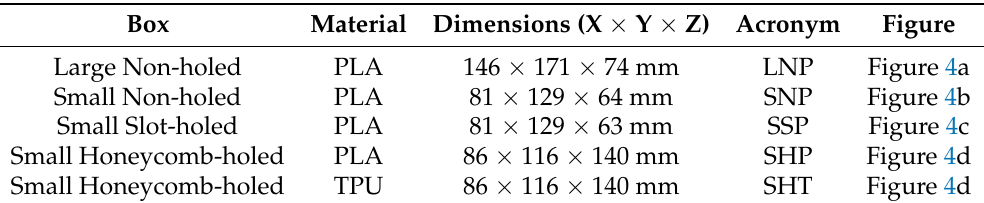
Table 3. Name of the created boxes, printing material, dimensions and the acronym used to iden- tify